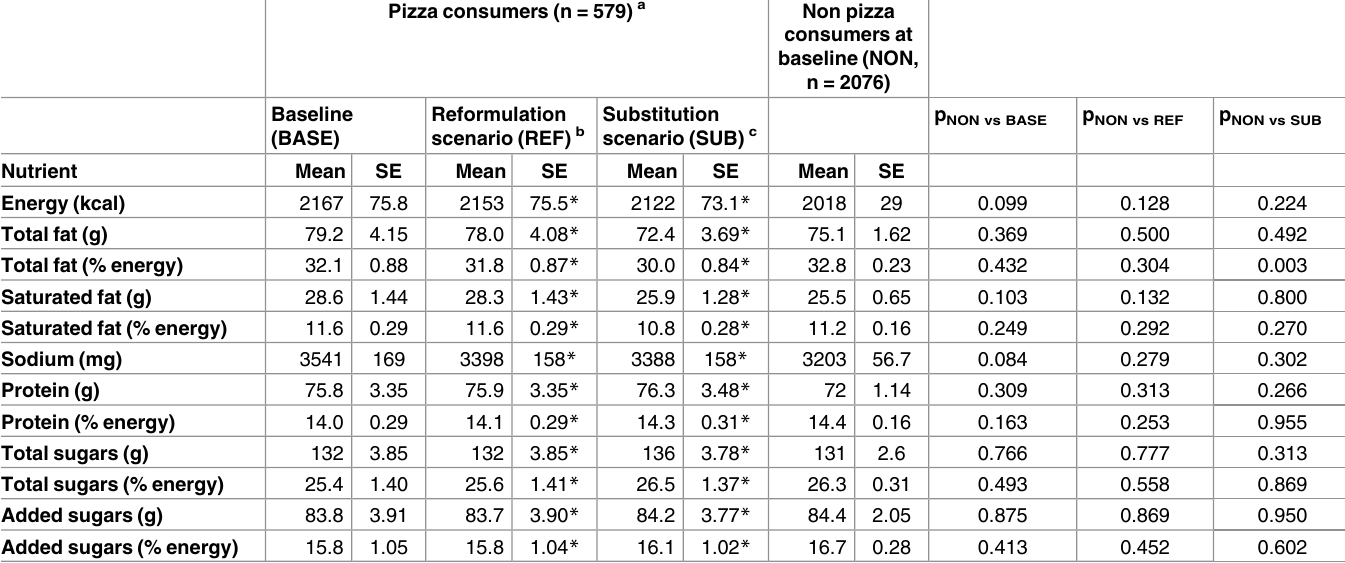
Table 4. Mean nutritional intakes in NHANES 2011–12children and adolescents aged 4 to 19 years (Day 1), at baseline and in the reformulation and substitution